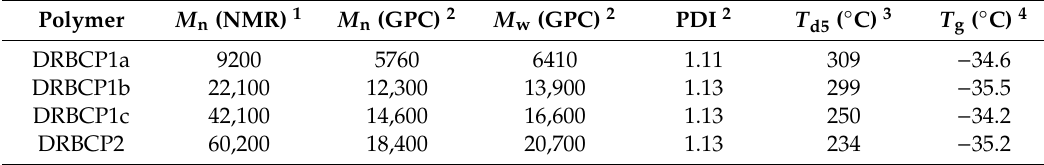
Table 2. Characterization of the DRBCPs.